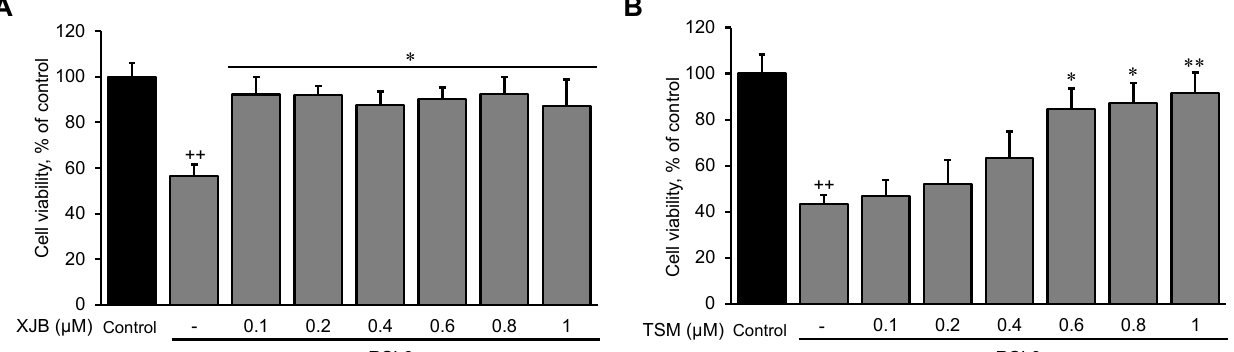
Figure 1. The effects of XJB and TSM on ferroptosis in H9c2 cells. Different concentrations of XJB ( A ) and TSM ( B ) in the presence or absence of 0.5 µ M RSL3. Cell death was calculated from the measurements by the Alamar Blue cell viability assay, and data are presented as a percentage of the control. GPX4 protein levels were calculated based on densitometry analysis using LI-COR Image Studio Lite and normalized to β -actin expression for each band. Data are presented as a percentage of the control group. ++ p < 0.01 vs. control; * p < 0.05 and ** p < 0.01 vs. RSL3. n = 3 per